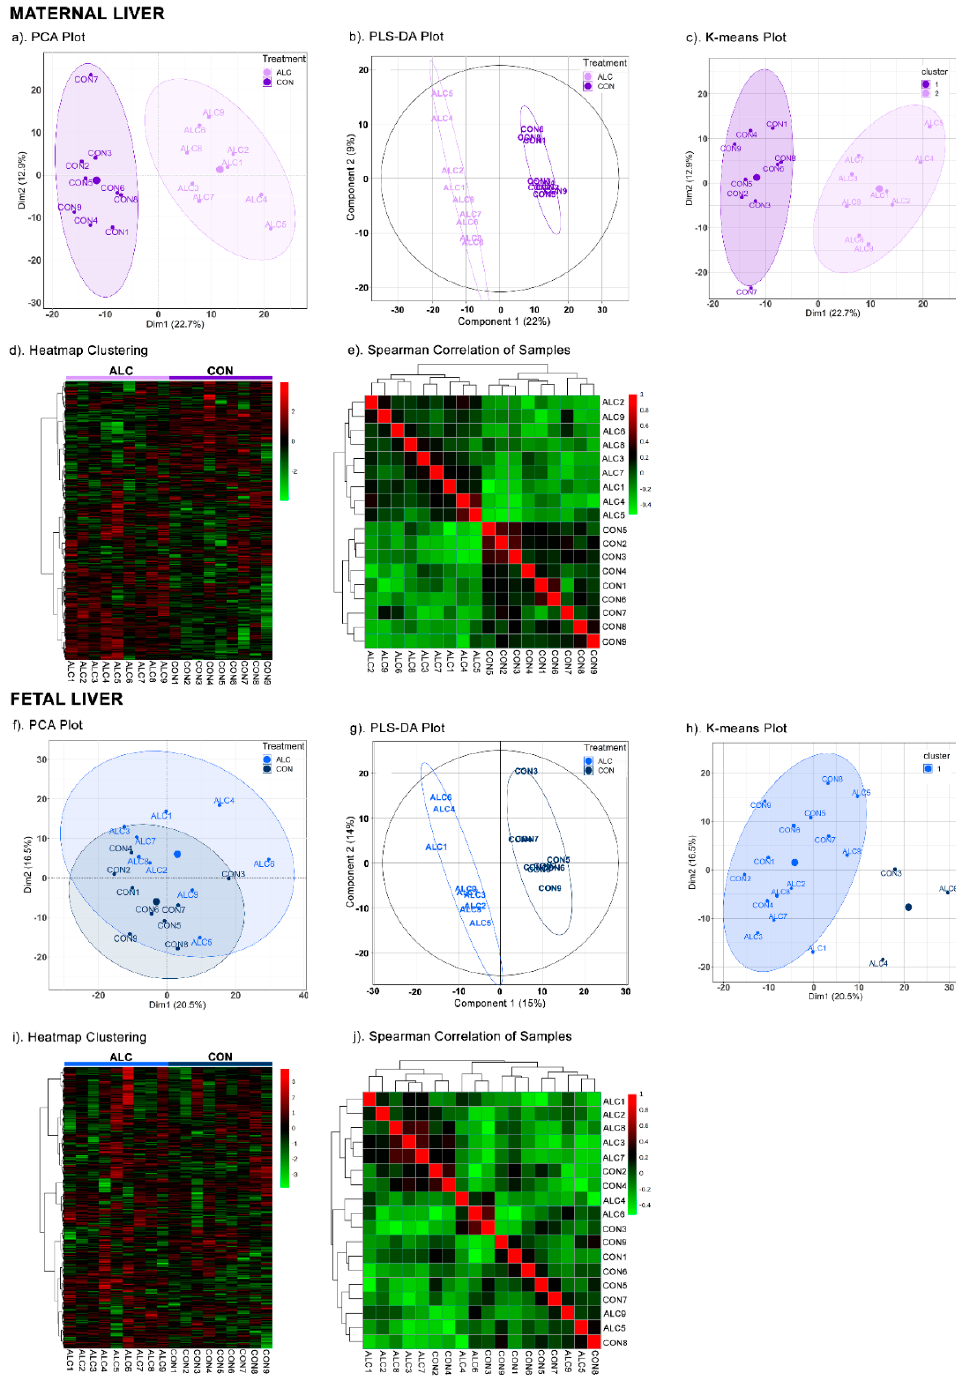
Figure 1. Multivariate analyses of maternal and fetal metabolite profiles. In maternal liver, PCA ( a ), PLSDA ( b ), K-means clustering ( c ), heatmap clustering ( d ), and Spearman correlation of samples ( e ) clearly separated the ALC vs. CON groups. Whereas, in fetal liver, only PLSDA ( g ) separated the ALC vs. CON groups with a variance of 15% in Component 1. PCA ( f ), K-means clustering ( h ), heatmap clustering ( i ), and Spearman correlation of samples ( j ) were unable to separate the ALC vs. CON groups. The high, unchanged to low abundance values of metabolites in both groups are represented by a gradient of red to green color in heatmaps. In correlation of samples, positive, unchanged and negative correlations are represented from the red to green color. N = 9 each for the CON and ALC maternal and fetal samples, N = 724 for the